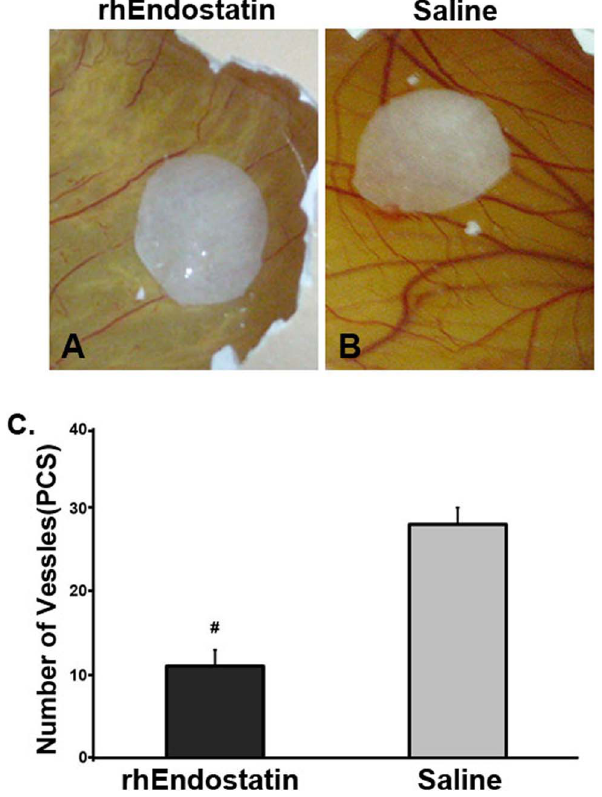
Figure 3. In vivo inhibition of angiogenesis using chicken embryo CAMs. Treated with rhEndostatin at 6 m g/disc ( A ), or treated with saline vehicle control disc ( B ) the vessels numbers were calculated(n=8, each) in CAMs assay after 10 days treatment, and data were presented as mean 6 SD. # indicated P , 0.05. ( C ).